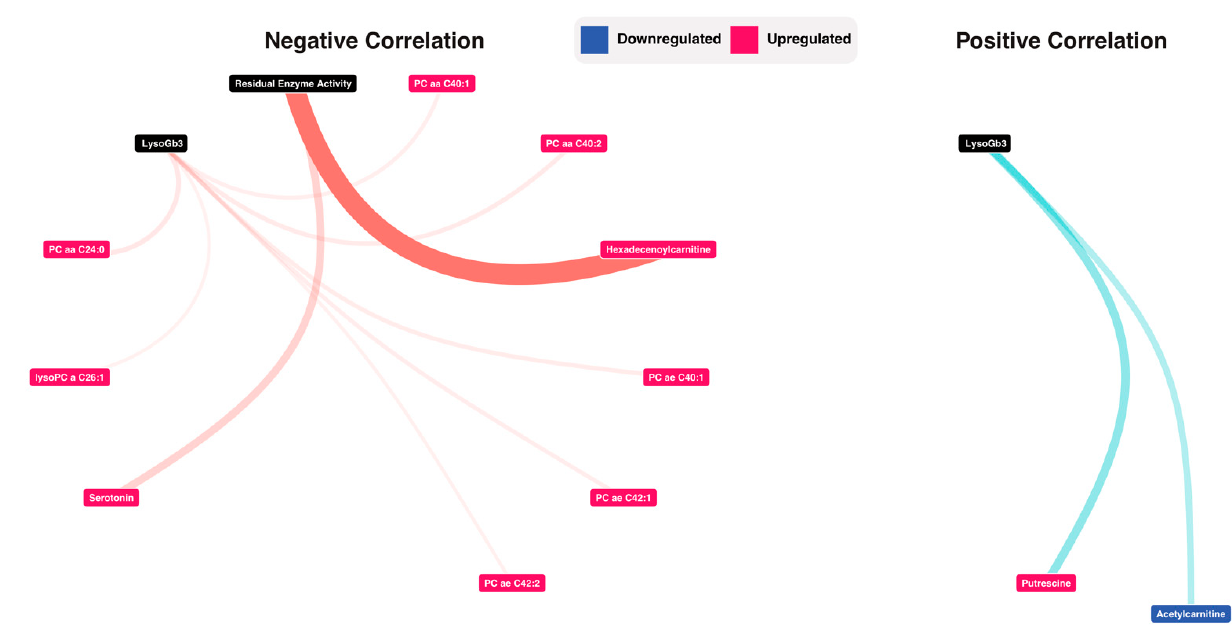
Figure 5. Correlation analysis between LysoGb3, Residual enzyme activity and the metabolomic data. Detailed results are presented in supplementary Table S7.